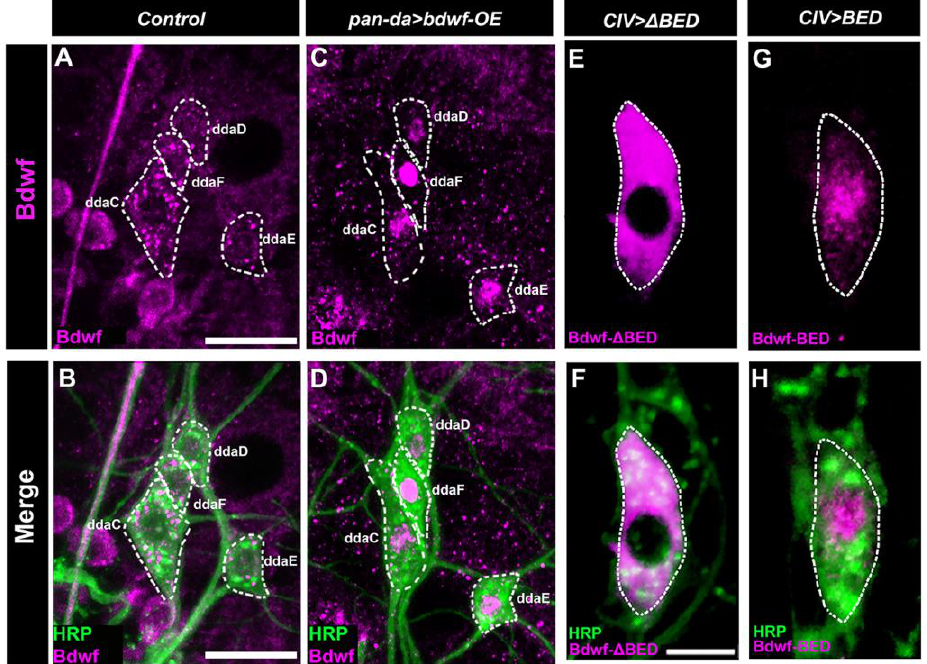
Figure 3. Bdwf exhibits nucleo-cytoplasmic localization. ( A – D ) Representative confocal image of WT and Bdwf overexpressing dorsal cluster da neurons labeled with HRP (green) and anti-Bdwf antibody (magenta) to mark md neurons and Bdwf. md neuron cell bodies are highlighted by dotted white lines to represent Bdwf expression and localization in class I, III, and IV neurons. In wild-type, Bdwf shows weak nuclear localization and strong punctate cytoplasmic expression ( A , B ). Overexpression of bdwf transgene with the pan-da GAL4 217 driver produces a dramatic increase in nuclear localization ( C , D ) compared to wild-type while retaining punctate expression in the cytoplasm. Note that Bdwf is also expressed in puncta in surrounding epithelial and muscle tissue that is not labeled by HRP. Scale bar represents 20 µm. ( E – H ) BED domain is essential for Bdwf nuclearization. Representative confocal images of CIV md neurons expressing either UAS-bdwf-BED or UAS-bdwf- ΔBED using a class-IV specific driver. md neurons are immunolabeled with FITC-HRP (green) and anti-HA antibody (Magenta) to mark neurons and Bdwf mutant variants. Scale bar represents 5 µm. Genotypes: GAL4 217 /+; +/+ ( A , B ), GAL4 217 /+; UAS – bdwf – FLAG – HA/+ ( C , D ), GAL4 477 /UAS – bdwf – ΔBED – myc; +/+ ( E , F ), GAL4 477 /UAS – bdwf – BED – HA;+/+ ( G , H ).